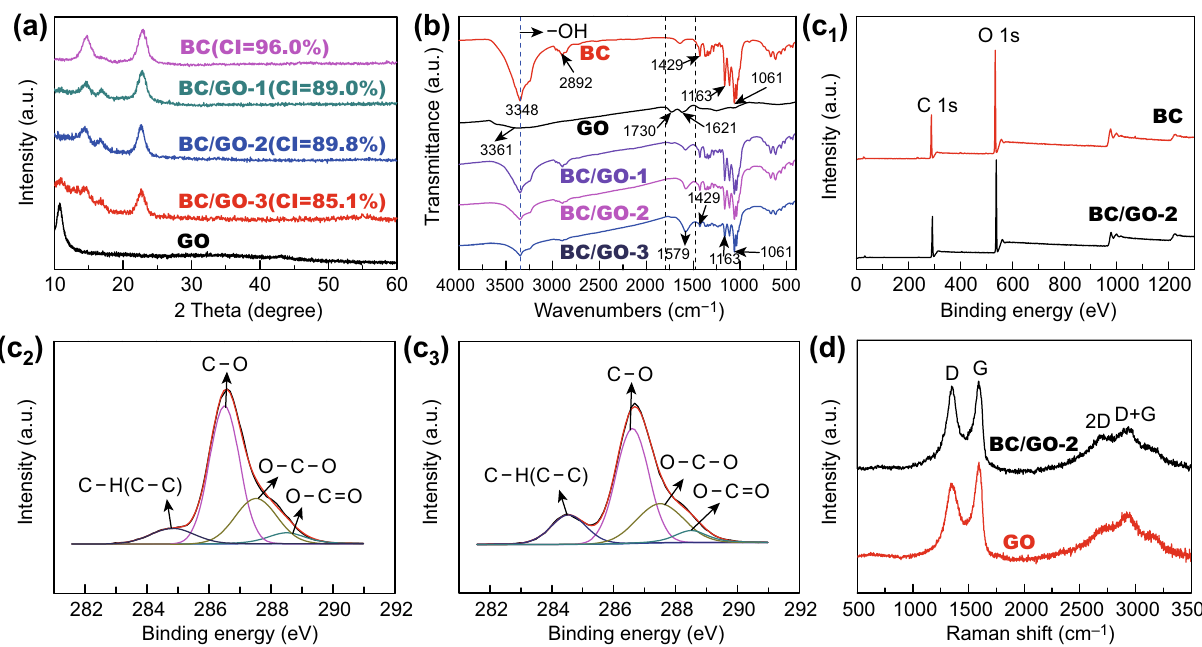
Fig. 3 a XRD patterns of BC 0 , BC, and BC/GO nanocomposites. b FTIR spectra of BC, GO, and BC/GO nanocomposites. c Wide-scan XPS spectra of BC and BC/GO-2